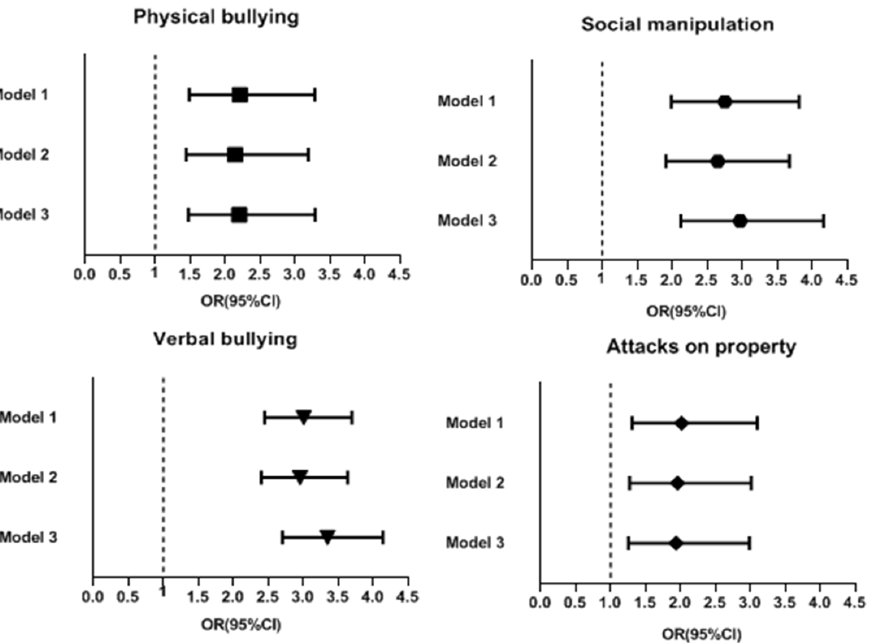
Figure 3. Crude ORs and adjusted odds ratios for the incidence of various kinds of bullying per ‐ petration before and during the pandemic (error bars represent 95% confidence